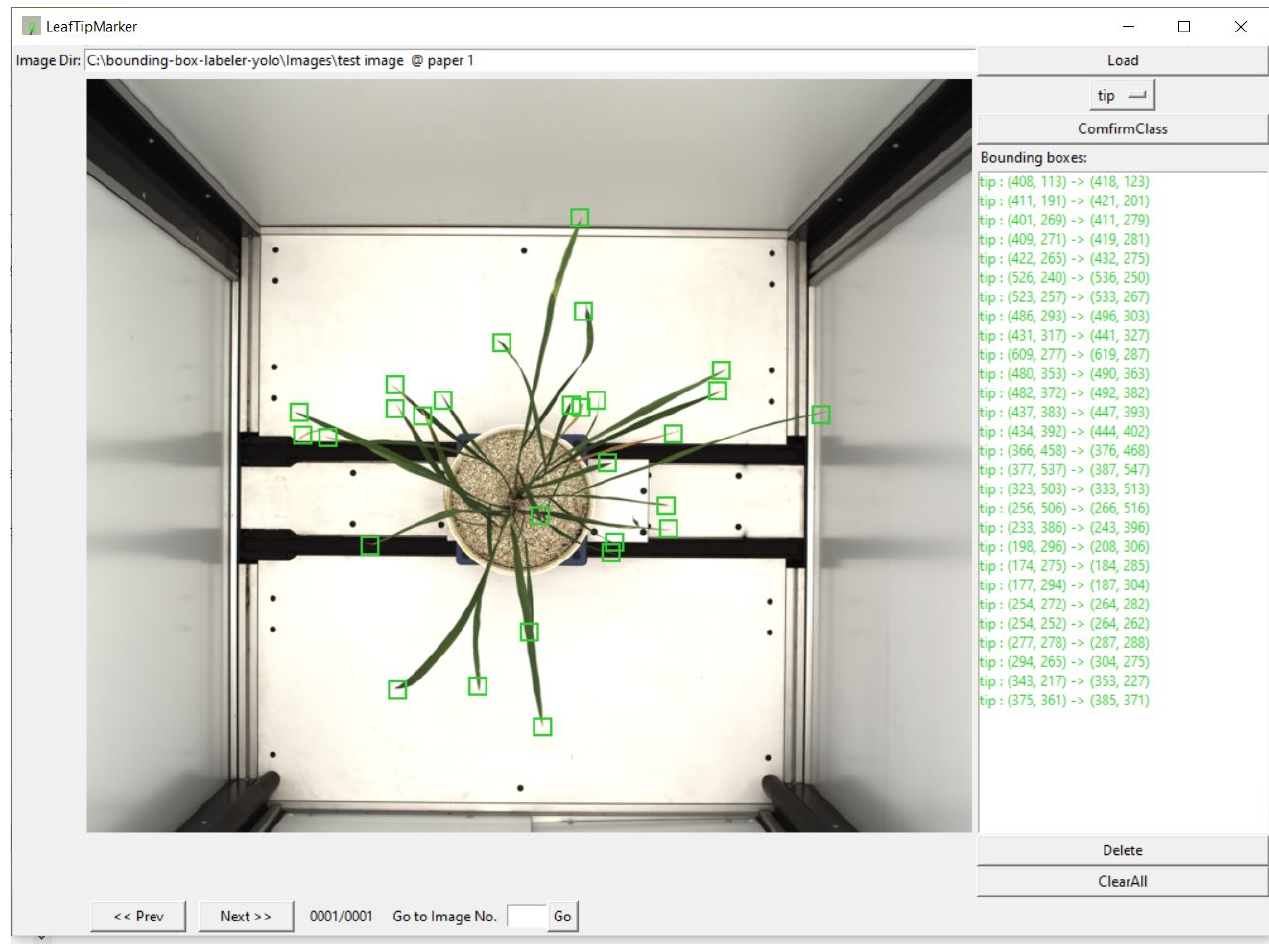
Figure 5. Annotation of leaf tips in a rice plant, using LeafTipMarker software.